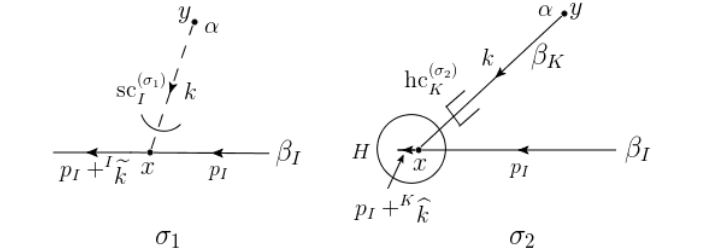
Figure 12. Subgraphs of two leading pinch surfaces (cid:27) 1 and (cid:27) 2 of A . The propagator with momentum k (cid:22) is soft in (cid:27) 1 , while collinear to (cid:12) (cid:22) t (cid:27) A , the momentum k (cid:22) appearing in ( p I + k ) (cid:22) is replaced by I e k (cid:22) = ( k (cid:1) (cid:12) I ) (cid:12) 1 is replaced by K b k (cid:22) =